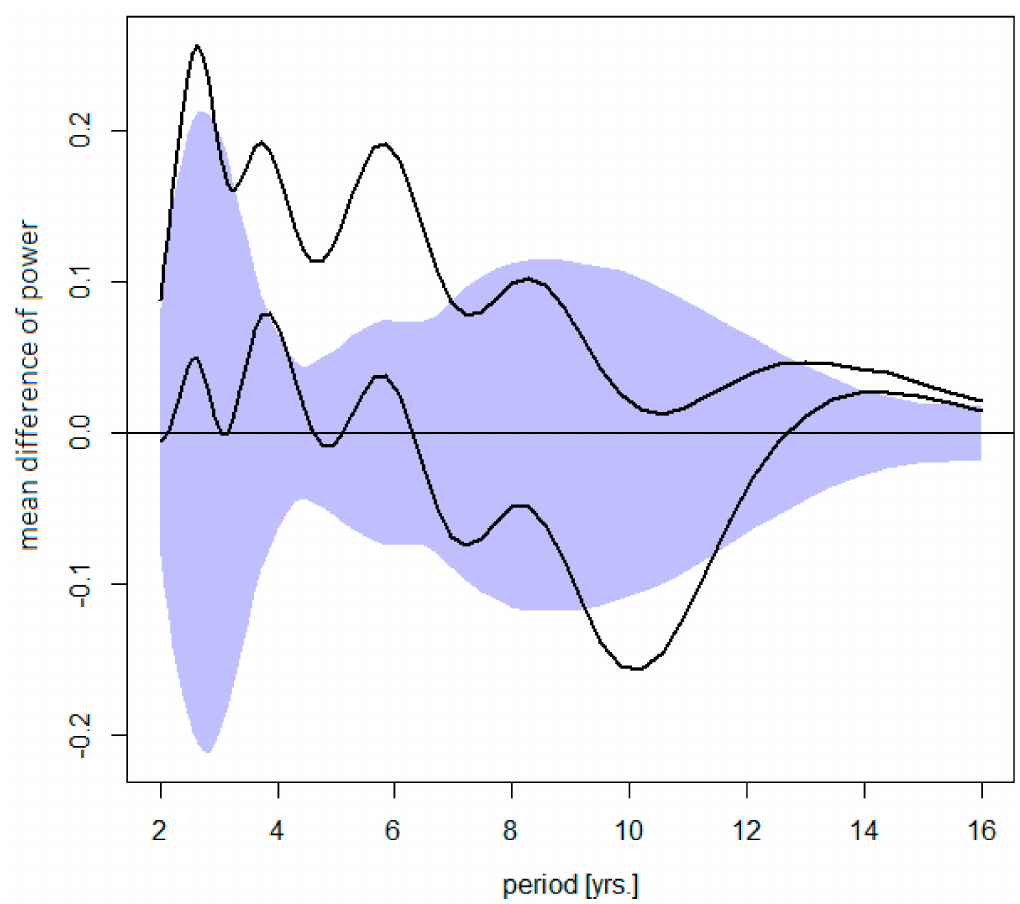
Figure 3. Di ff erence between the post- and pre-warming average wavelet power spectra of TBE fluctuations (the former minus the latter)—shown is the mean di ff erence for Sweden, the Czech Rep., Austria, and Slovenia altogether (upper diagram) counting in the trend, or (lower diagram) for stationarized data, plotted together with a 95% bootstrap confidence band for the mean di ff erence under H0 (R = 1000 simulations). The dominating quasi-biennial-, triennial-, pentennial-, and the oscillations in the decadal-band are discernible. Note that (upper) an increment in power gradually decreases from the shortest to the longest oscillations (i.e., short cycles contribute the most to an overall incidence rise ), and that (lower) a positive- next to a negative-signed deviations in the decadal band testifies for a shift towards longer